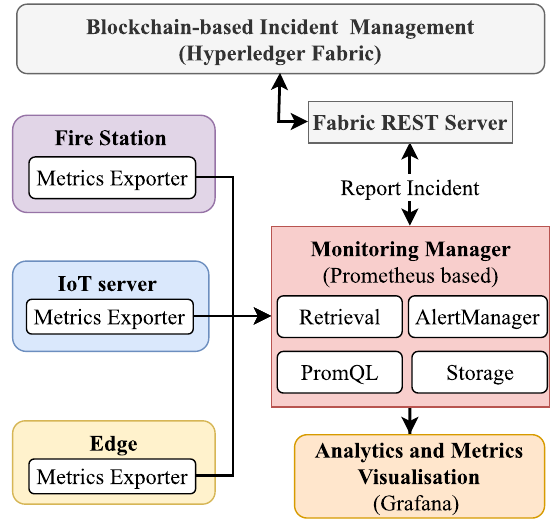
Fig. 9 Employing Prometheus monitoring tool for feeding metrics to the